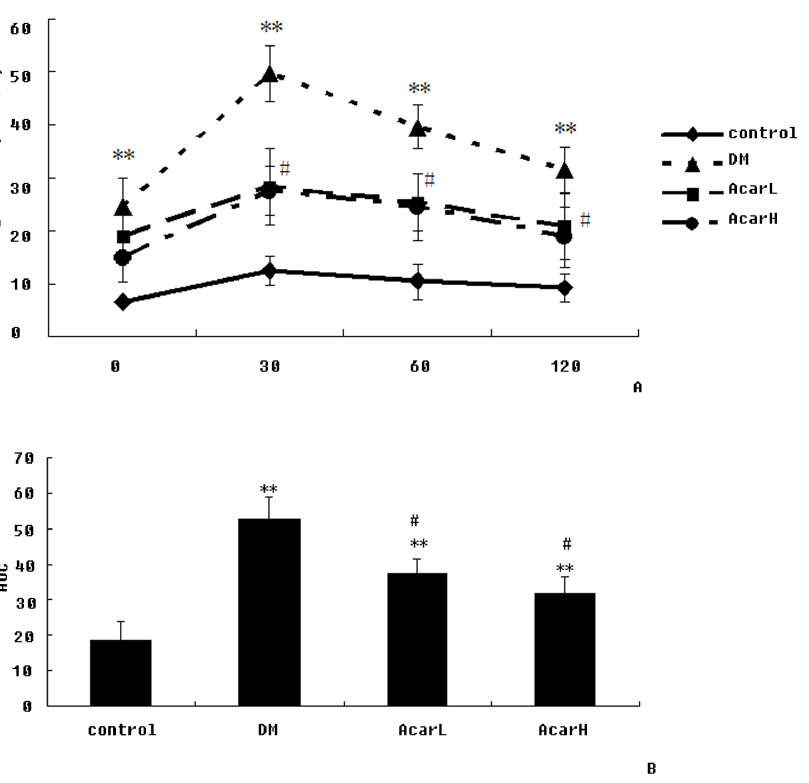
Figure 2. The effect of acarbose on oral glucose tolerance test blood glucose (A) and AUC (B) in rats. Data represent mean 6 SD (n=10 per group). ** P , 0.01 versus the control group; # P , 0.05 versus DM group.